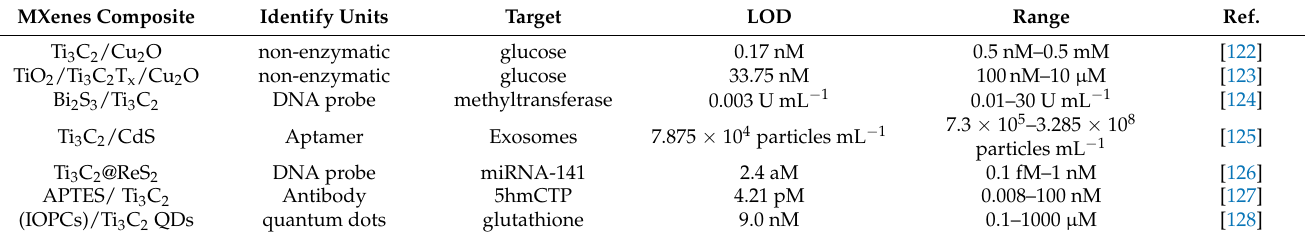
Table 6. MXene-based photoelectrochemical biosensors identify units, target, and analytical